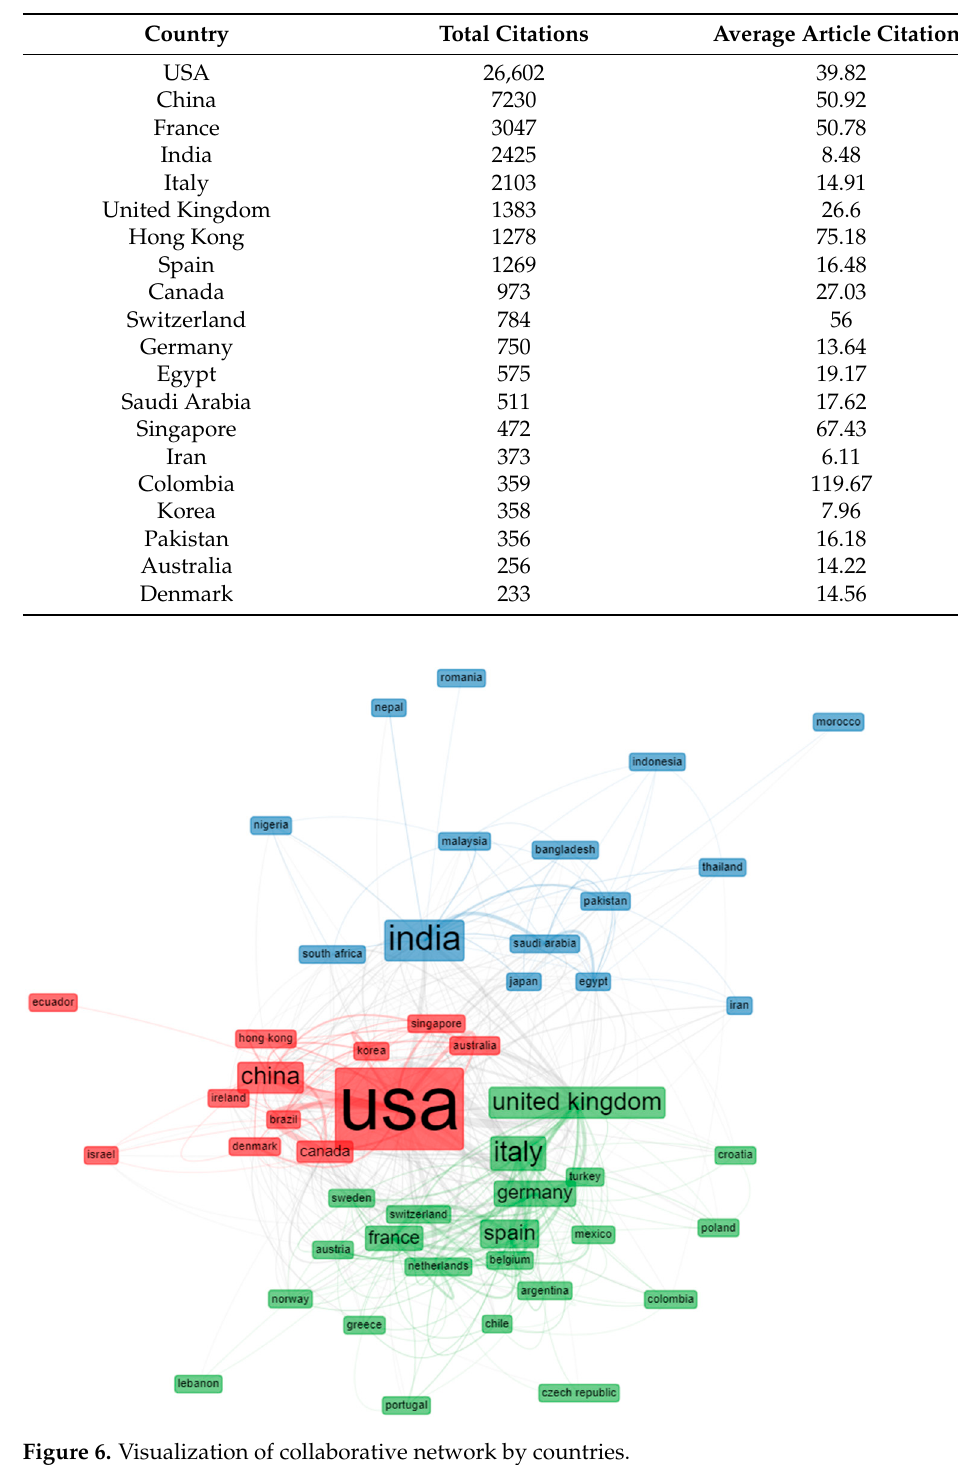
Table 5. Most cited countries with their total citations and average article citations.